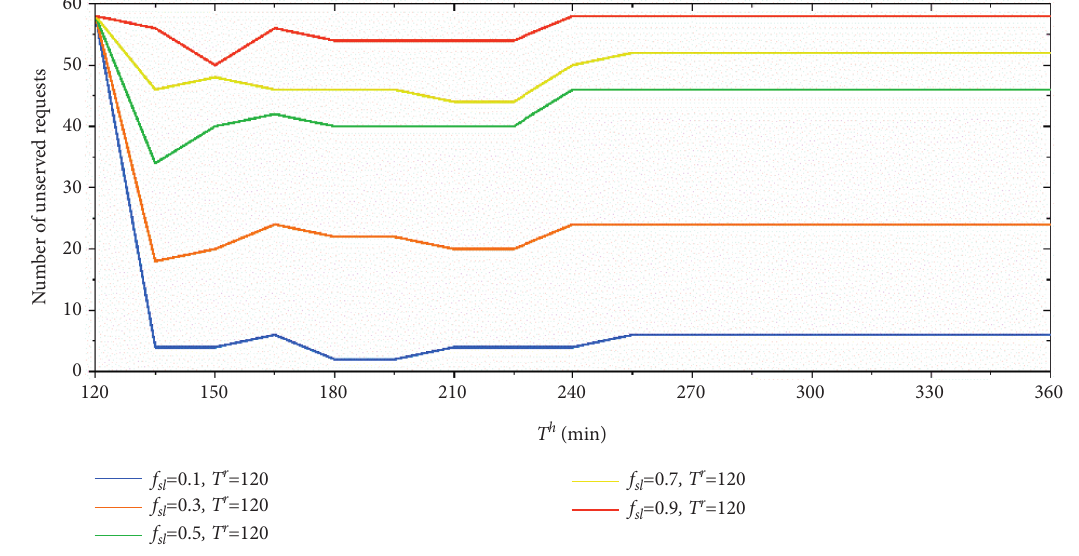
Figure 13: Results of the number of unserved requests.